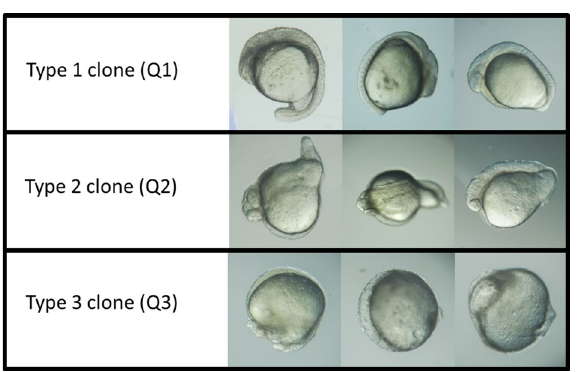
Figure 4. Ploidy and genetic identity of the embryos after nuclear transfer. ( a ) Distribution of the clones according to their ploidy at 24 h-stage (percentage of n = 55 clones). ( b ) Genetic identity of the clones (maternal, donor or both) within each ploidy class at 24 h-stage. ND not determined (see text).